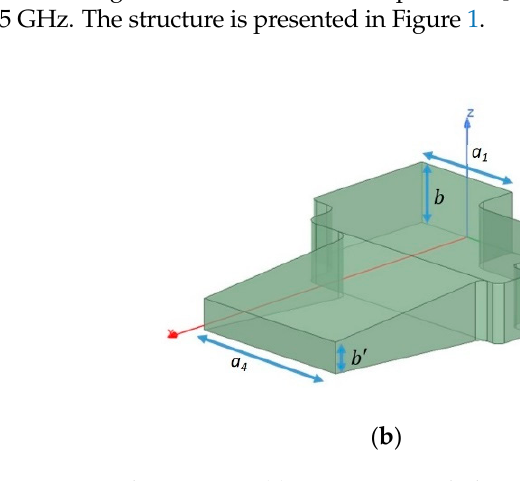
Figure 1. Structure of the TE10 to TE20 mode converter: ( a ) upper view with the 4 sections (1–4) of the converter and ( b ) 3D view .